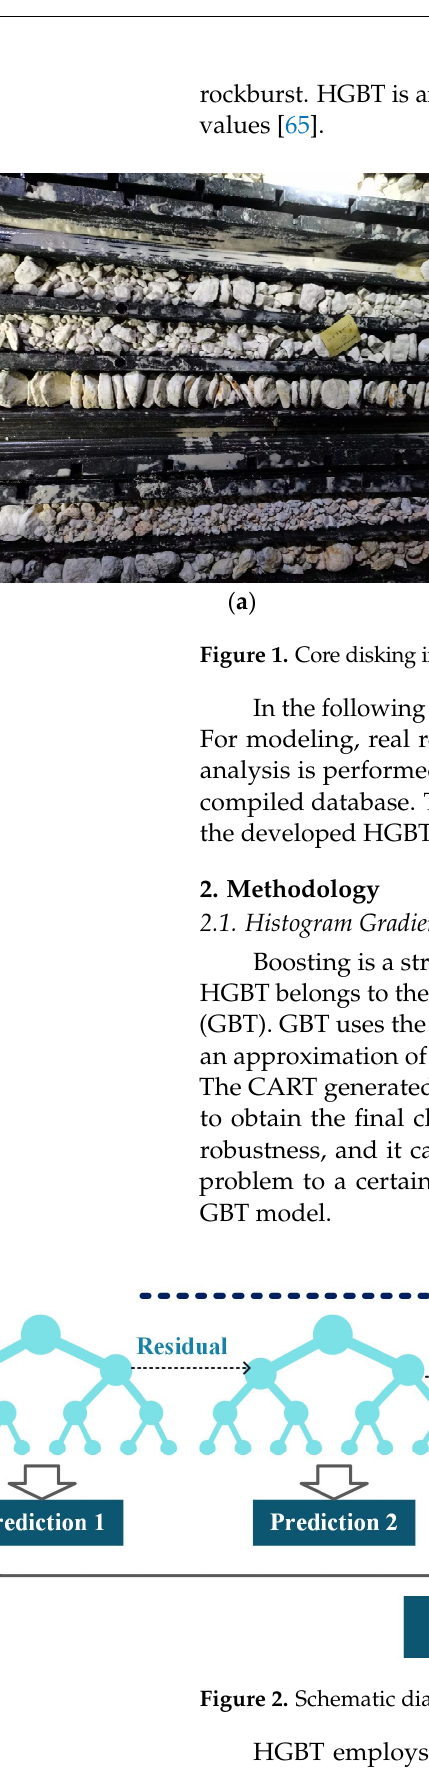
Figure 3. Schematic diagram for the histogram-based algorithm. 2.2. Hunger Games Search Hunger game search (HGS) algorithm is introduced to optimize the hyperparameters of the HGBT. HGS [66] was proposed based on starvation-driven activity and the behavior of animals. Animals rely on their sensory knowledge to survive under specific rules and interact with the environment. Animal survival, reproduction, and food opportunities are provided by their numerical logic rules. Hunger is the most important factor in animal life because it directly affects the body balance, behavior, decision, and action. Therefore, an- imals constantly seek food to maintain this balance and alternate between exploration, defense, and competition activities according to needs. The mathematical model of HGS is as follows (1)